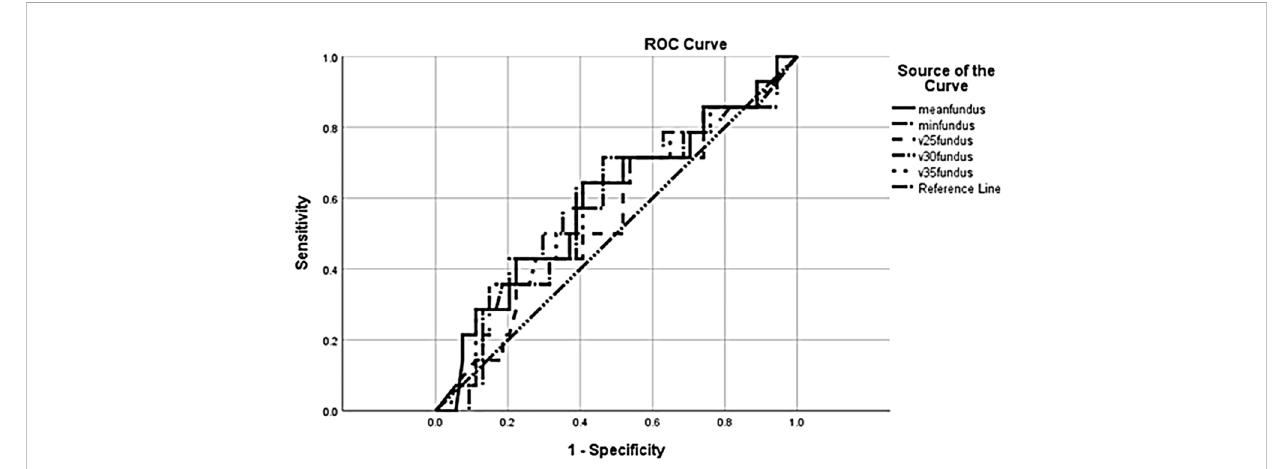
FIGURE 1 Receiver operating characteristic (ROC) curve for anastomotic leak in relation to radiation dose.